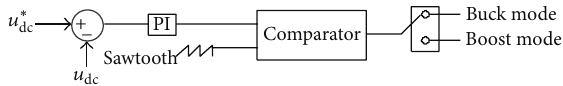
Figure 3: Bidirectional converter control system.